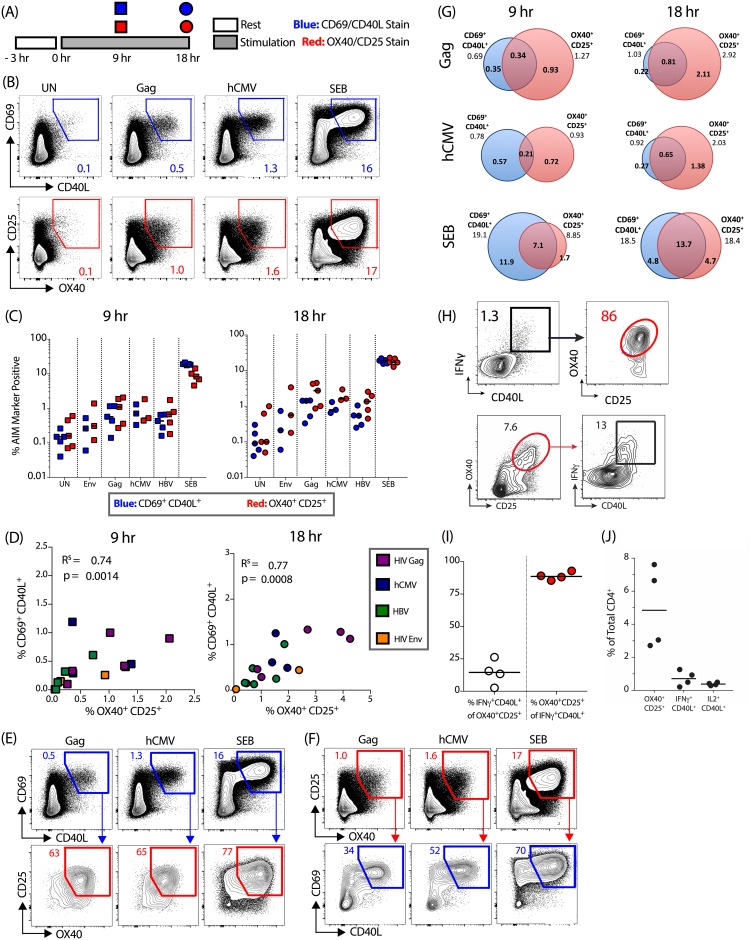
AIM markers identify overlapping populations of antigen-specific CD4 T cells.(A) Experiment protocol overview. Briefly, PBMCs were rested, then stimulated with antigen for 9-18hrs and stained for CD69, CD40L, OX40 and CD25 surface upregulation. (B) Example flow cytometry plots following 18-hr stimulation. (C) Quantification of data in (B) following a 9 hr (left) and 18 hr (right) antigen stimulation. CD69+CD40L+ is shown in blue and OX40+CD25+ in red. (D) Correlations between the two AIM assays following a 9 hr (left) and 18 hr (right) antigen stimulation. Data shown are background subtracted. Different antigens are indicated by color: HIV-1 Gag (purple), HIV-1 Env (orange), hCMV (dark blue) and HBV (green). Rs = Spearman's Rank correlation co-efficient with associated p values. (E,F) Example flow cytometry plots demonstrating the co-expression of different AIM at 18 hr post-antigen stimulation for (E) OX40/CD25 expression on CD69+CD40L+ CD4 T cells and (F) CD69/CD40L expression on OX40+CD25+ CD4 T cells. Numbers shown in bottom row indicate percentage from parent gate. (G) Quantification of data in (E,F). Venn diagrams illustrate overlap between the two AIM marker+ populations. All numbers represent mean percentages of AIM marker+ cells from total CD4 T cells. For (B-G) n = 3–5 HIV-infected, hCMV-positive donors per antigen. (H,I) Example flow cytometry plot showing OX40/CD25 expression on cytokine-producing cells (ICS CD40L+IFNγ+, top panels), and cytokine production from OX40+CD25+ cells (bottom panels), (M. mulatta PBMC). (I) Quantification of (H). (J) Detection of antigen-specific CD4 T cells by AIM vs. cytokine assays (M. mulatta PBMC). Cells from vaccinated animals were stimulated with BG505 antigen for a total of 21 hr with Brefeldin A added in the final 4 hrs. For H-J, n = 4 animals.